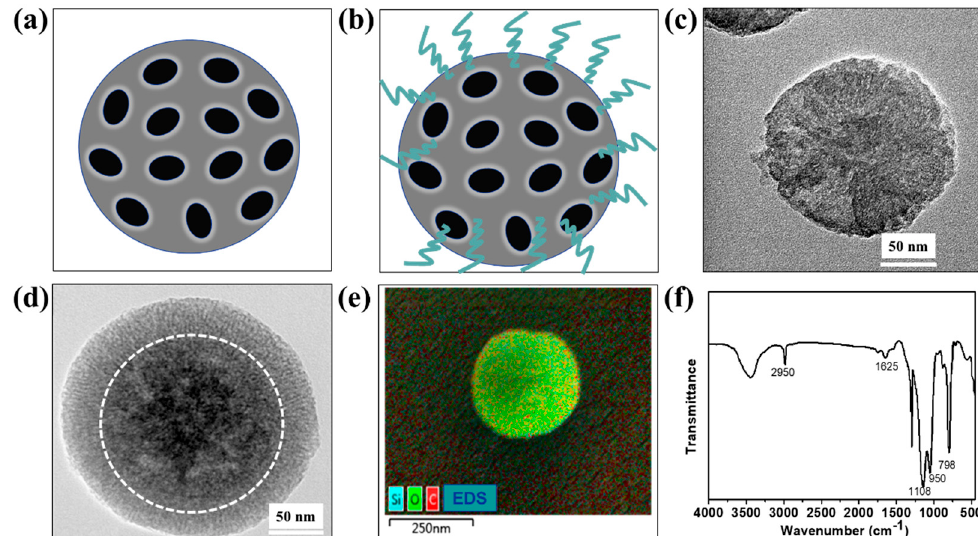
Figure 3. Mesoporous silica nanospheres used in the study. ( a , b ) are illustrations of bare mesoporous silica nanospheres and mesoporous silica nanospheres modified with 3-(aminopropyl) triethoxysilane (APTES). ( c , d ) are the corresponding transmission electron microscopy (TEM) images, ( e ) chemical composite, and ( f ) Fourier transform infrared spectroscopy (FTIR) spectrum of mesoporous silica nanospheres modified with APTES.